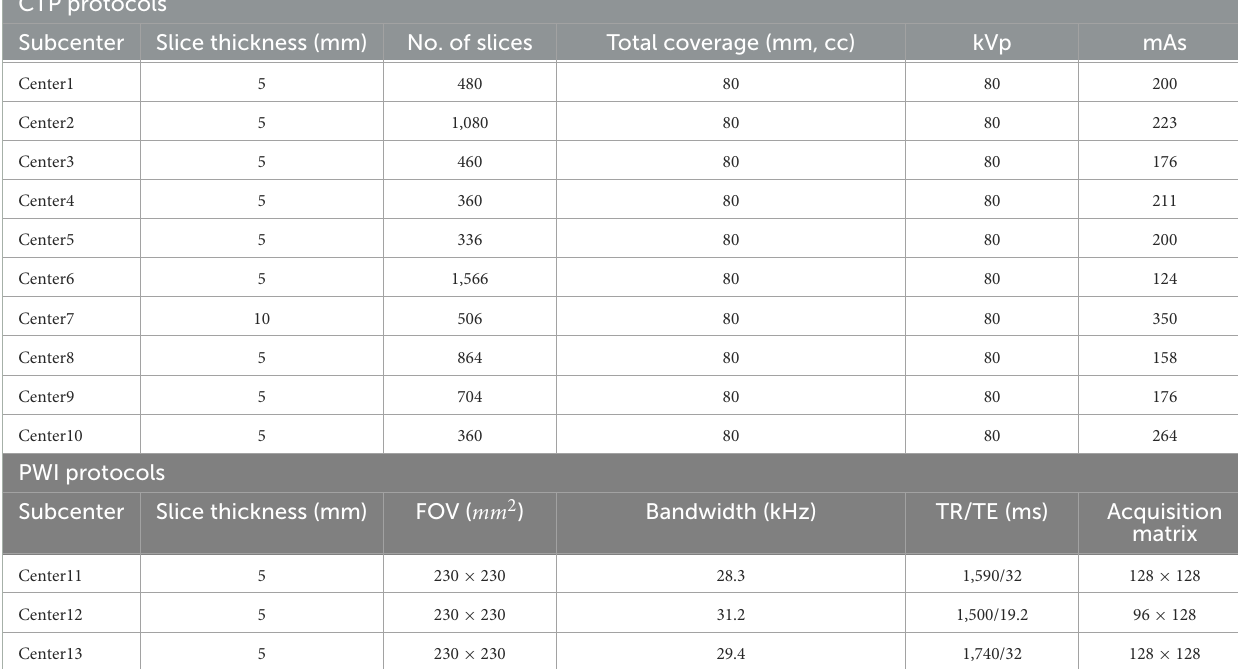
TABLE 1 List of imaging